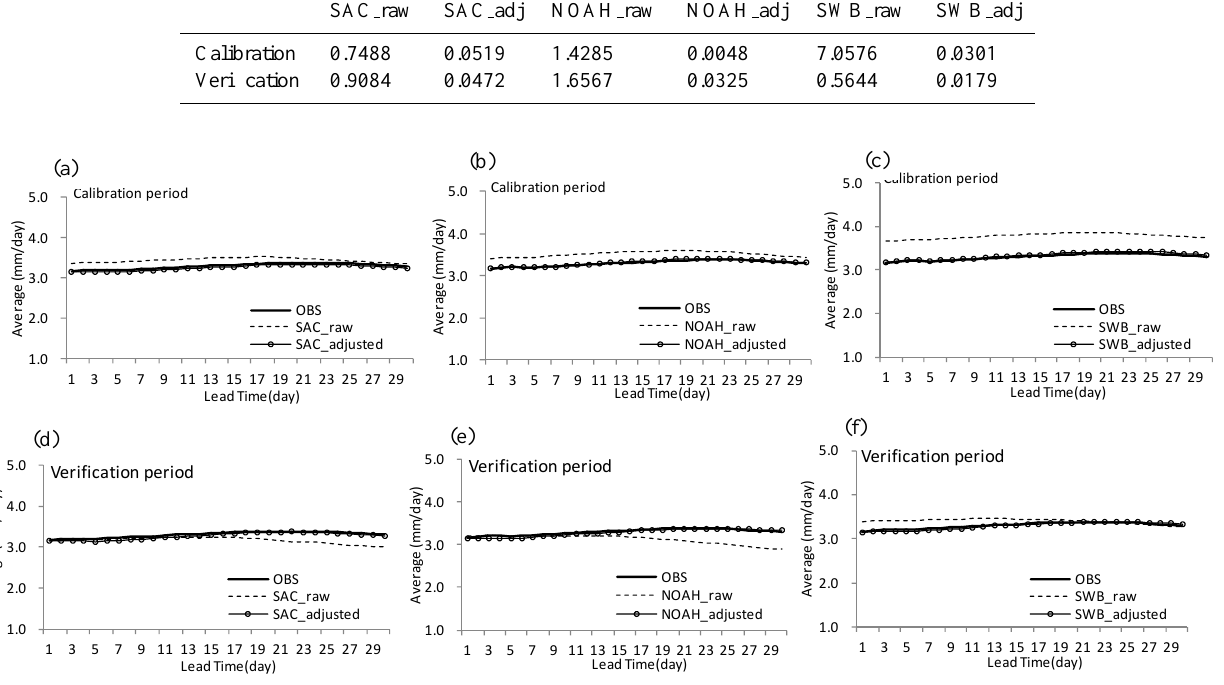
Table 1. RMS errors of raw and GLMPP adjusted ensemble means.